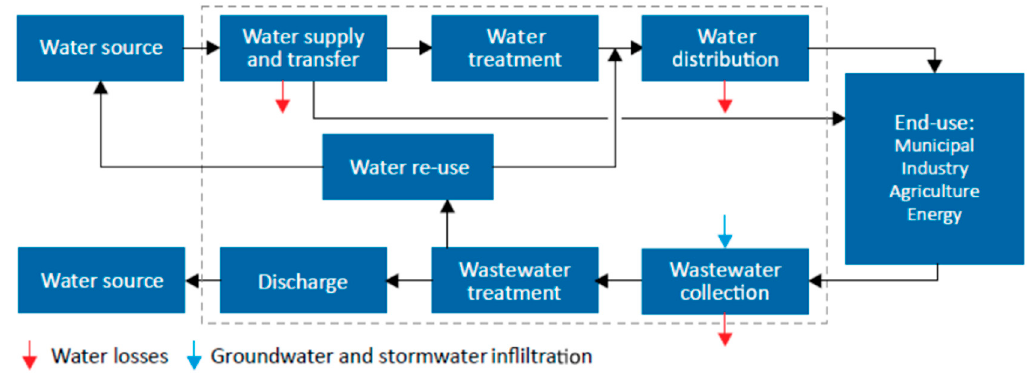
Figure 4. Energy need in each step of the water process [31].